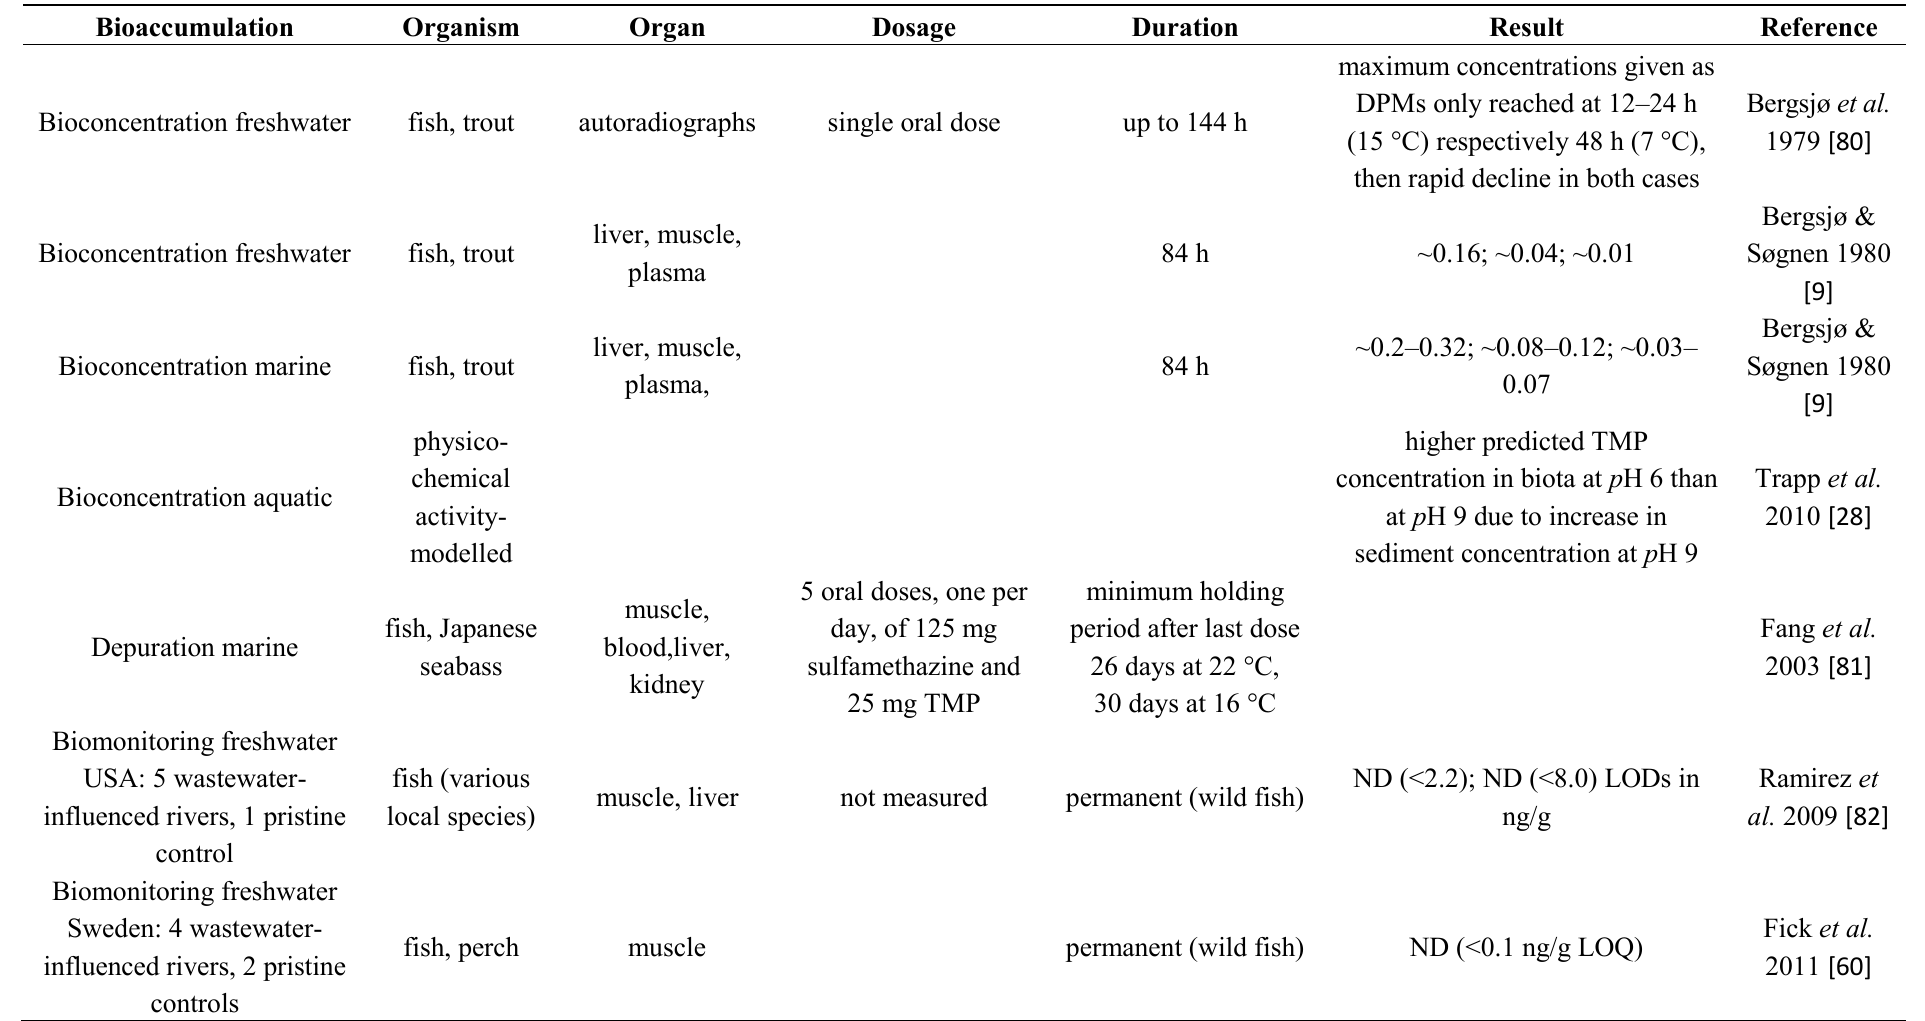
Table A5. Bioaccumulation data for